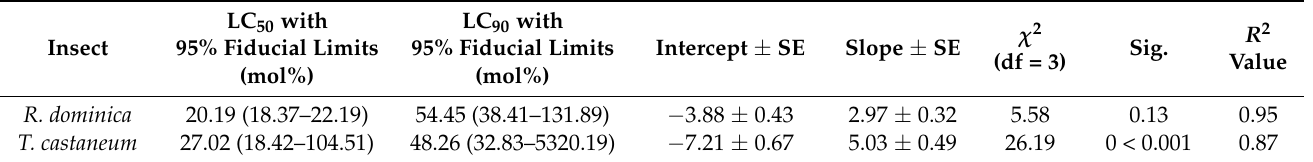
Values with different letters within each column are statistically different according to the Tukey’s test at p < 0.05. Asterisks indicate significant effects of CO 2 concentrations on mortality of insect pests, according to the results of the analysis of variance (ANOVA). SE is standard error. Table 2. Probit analysis of the toxicity of CO 2 on the adult-insects of R. dominica and T. castaneum .